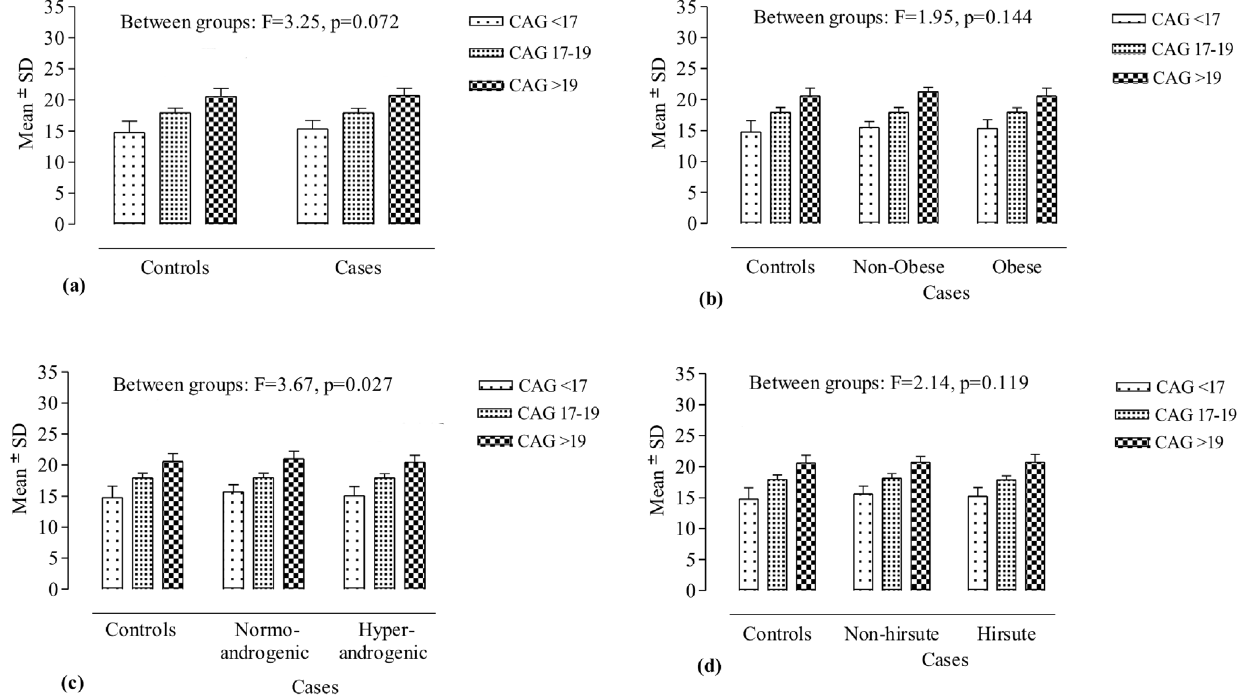
Figure 2. CAG bi-allelic mean distribution. Comparison of bi-allelic mean data in three CAG categories (short, moderate and long alleles) between cases and controls (a), and between controls and case subgroups based on obesity (b), androgenism (c), and hirsutism